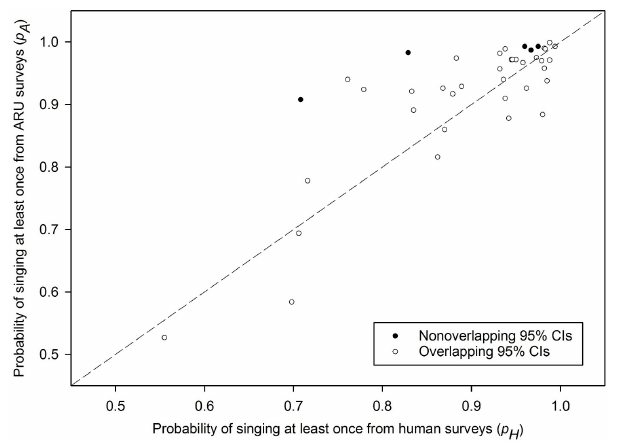
Fig. 2 . Relationship between probability of a bird singing at least once (and being detected) during a 10-minute point count survey estimated from count-removal models fit to data from 41 species from simultaneous point counts conducted by human observers in the field (x-axis) versus from autonomous recording units (ARUs, y-axis). Dashed diagonal line